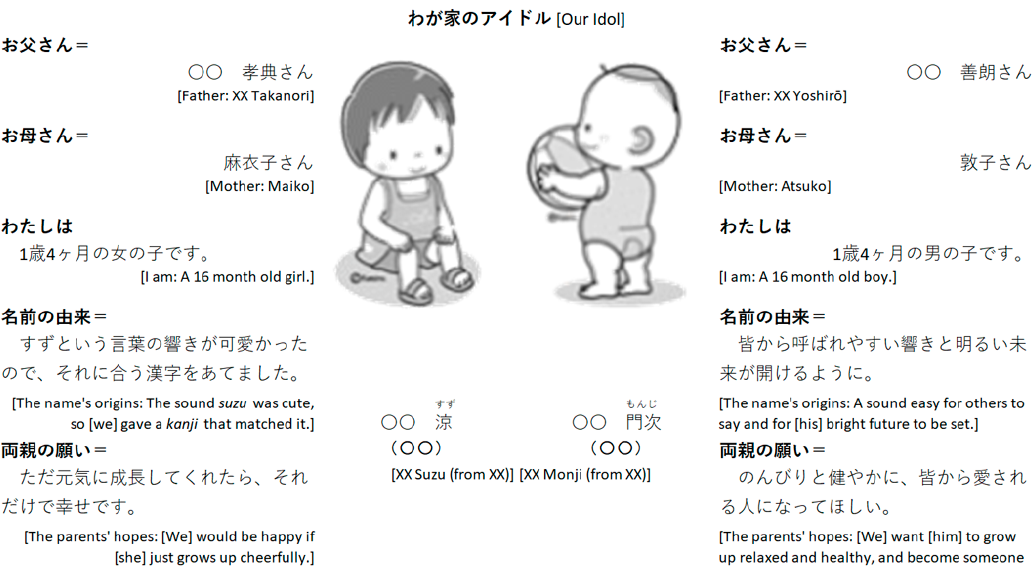
Figure 2. A modified example from the parents’ messages in K ō h ō Otobe . XX indicates details redacted for privacy. Example based on Otobe General Coordination Department, Planning Section (2015b). English not in original; this modified version originally in Japanese in Unser-Schutz (2018). Clipart from http://www.fumira.jp/.